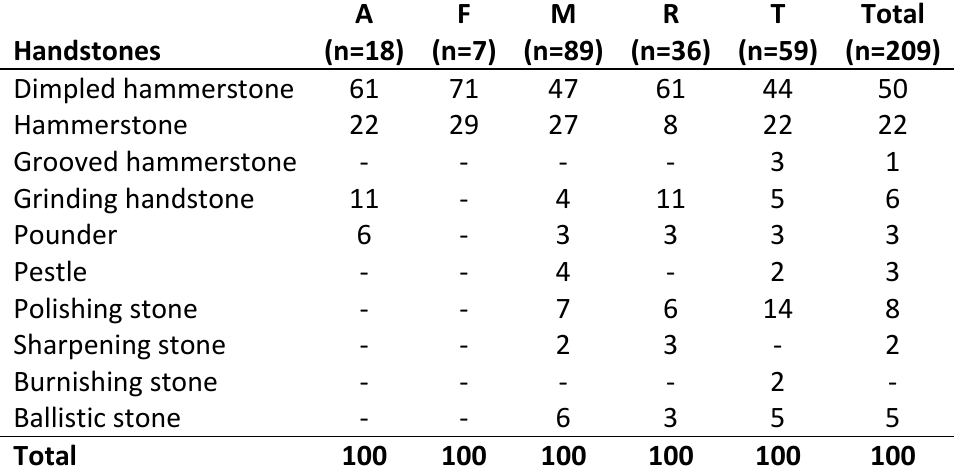
Table 3. Handstone type frequencies by excavation area. Chi Square = 30.240; Degrees of freedom = 36; p-value = 0.739. As the computed p-value is greater than the significance level alpha = 0.05, one cannot reject the null hypothesis H0: the rows and columns are independent.